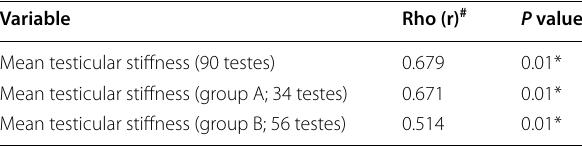
Table 3 Correlation between varicocele grade and mean testicular stiffness